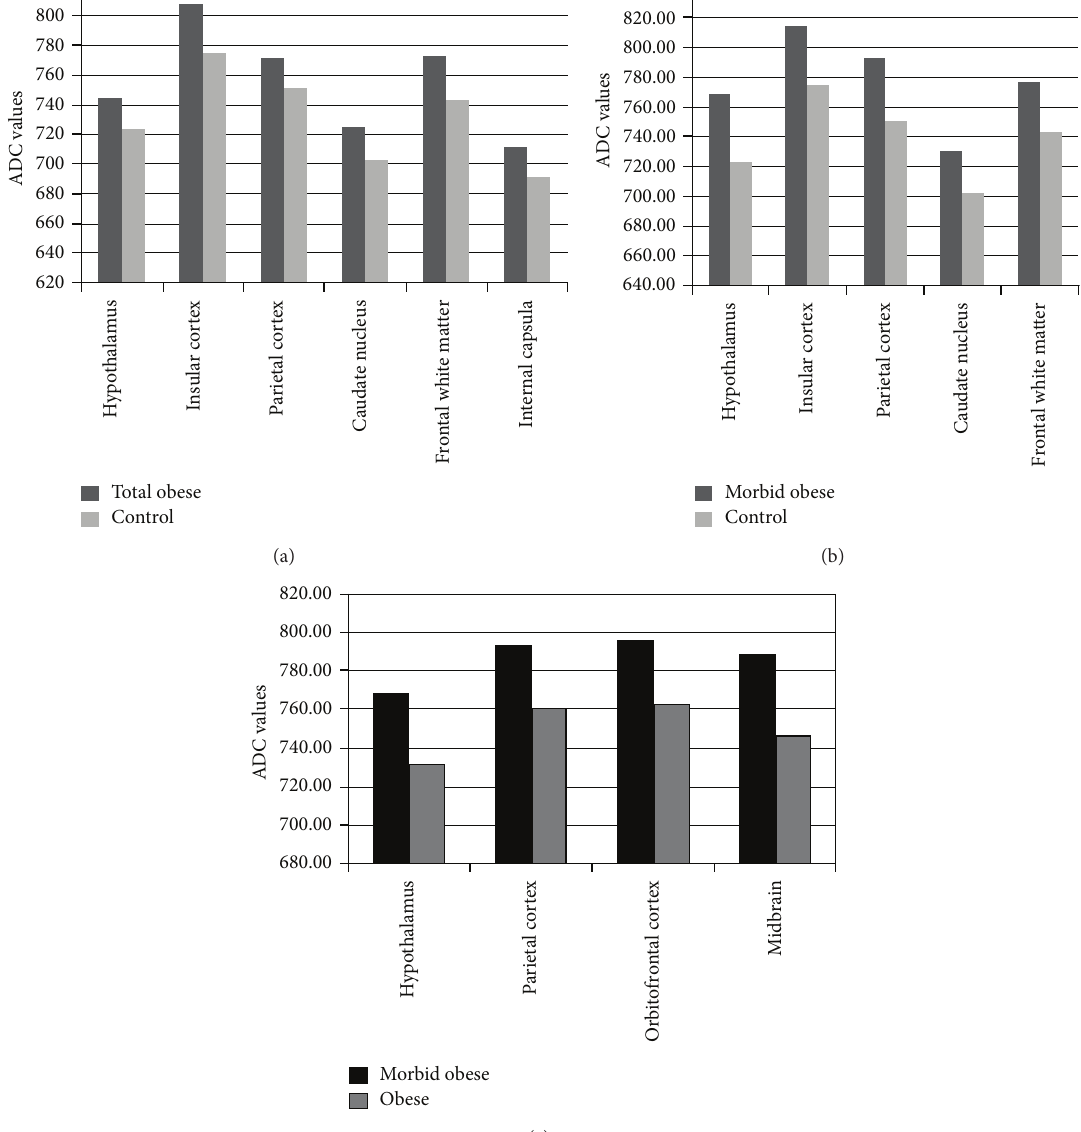
of upper airway throughout sleep. The prevalence of OSA in adult is 2–4% [1]. This ratio is similar worldwide and does not show regional differences [12]. OSA begins as benign snoring and increasing with weight and age